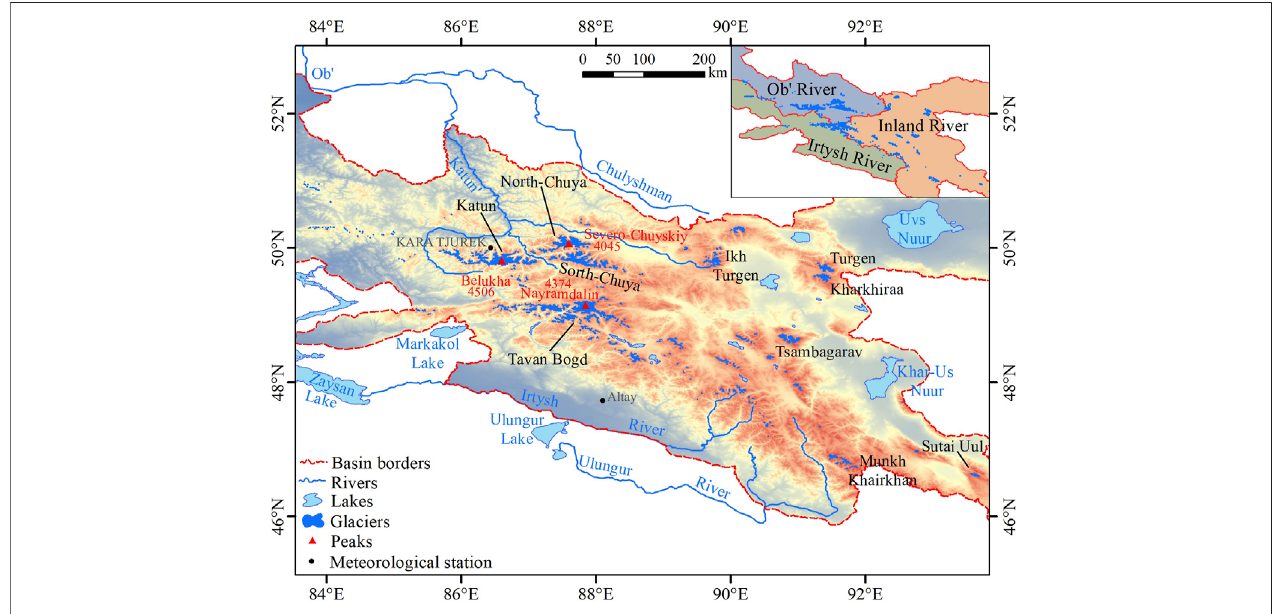
FIGURE 1 | Location of glaciers in the Altai